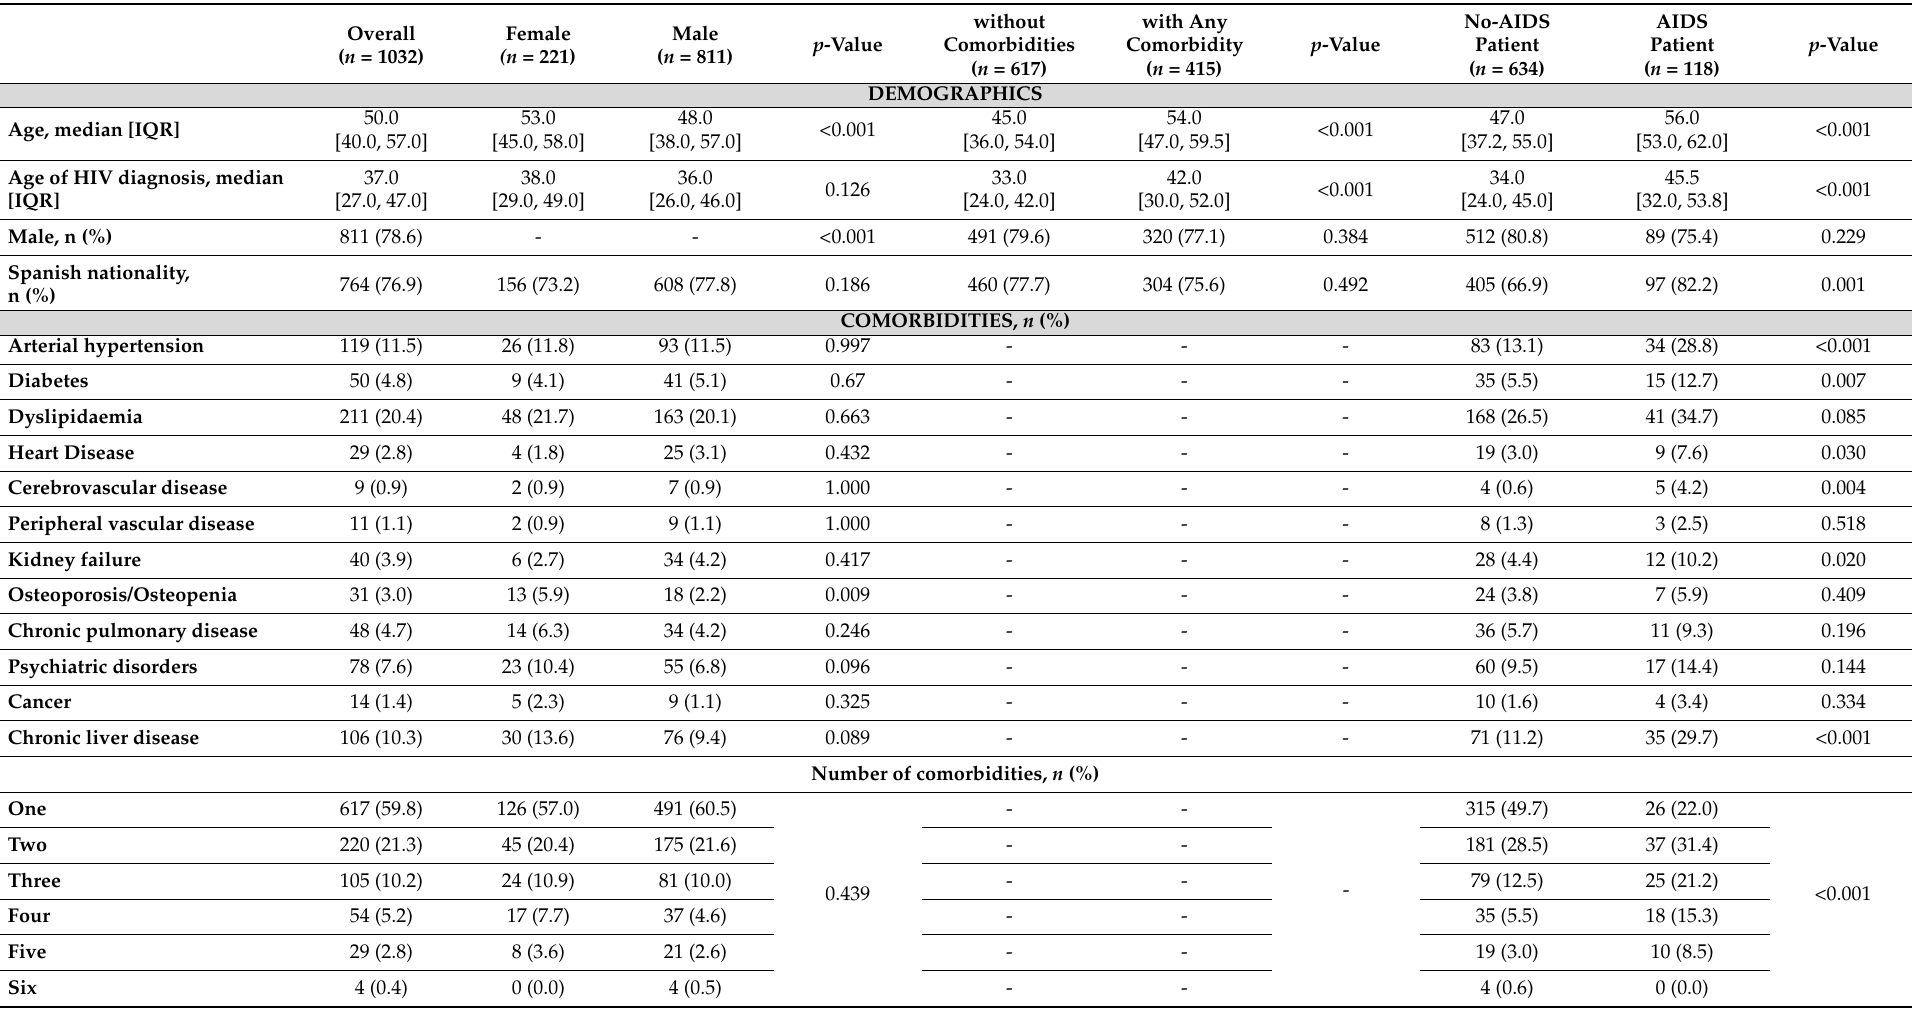
Table 1. Main characteristics of HIV patients treated with DTG plus 3TC by sex, presence of comorbidities, and